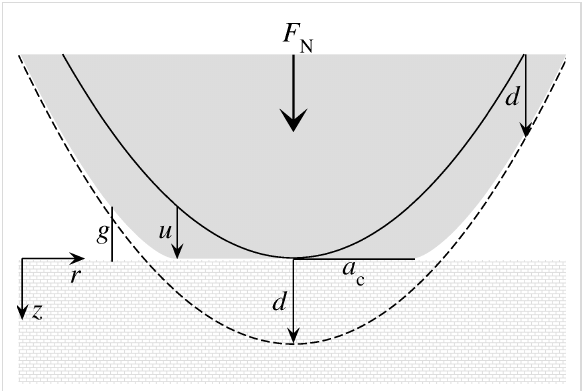
Figure 1: Geometry of the deformed tip (upper grey solid), the sub- strate (lower solid), and the reference tip (solid line). The dotted line represents a hypothetical tip that is allowed to penetrate the substrate the distance d into the substrate without deforming. The following vectors are introduced in the sketch: Normal load F N acting on the center of mass of the tip, the elastic displacement field u , and the dis- placement d of the tip’s center of mass. In addition, two scalar quan- tities, namely the contact radius a c and the gap (field) g are